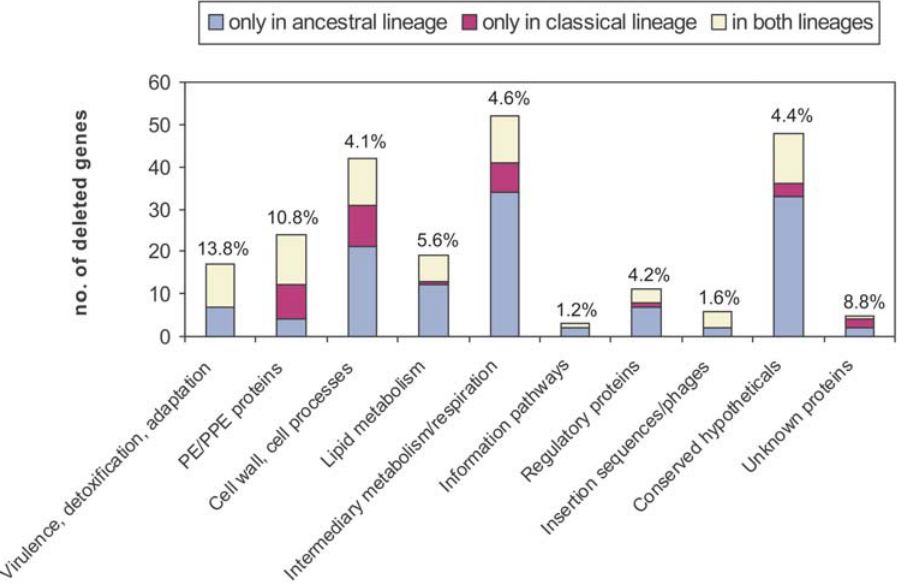
Figure 4. Numbers of CDSs deleted in M.ulcerans lineages. CDSs were subdivided in being deleted only in the ancestral lineage (light gray), only in the classical lineage (dark gray), or in both lineages (white). The percentage of silenced CDSs per functional category when set in relation to the respective number of genes in the whole genome is indicated above the bars.